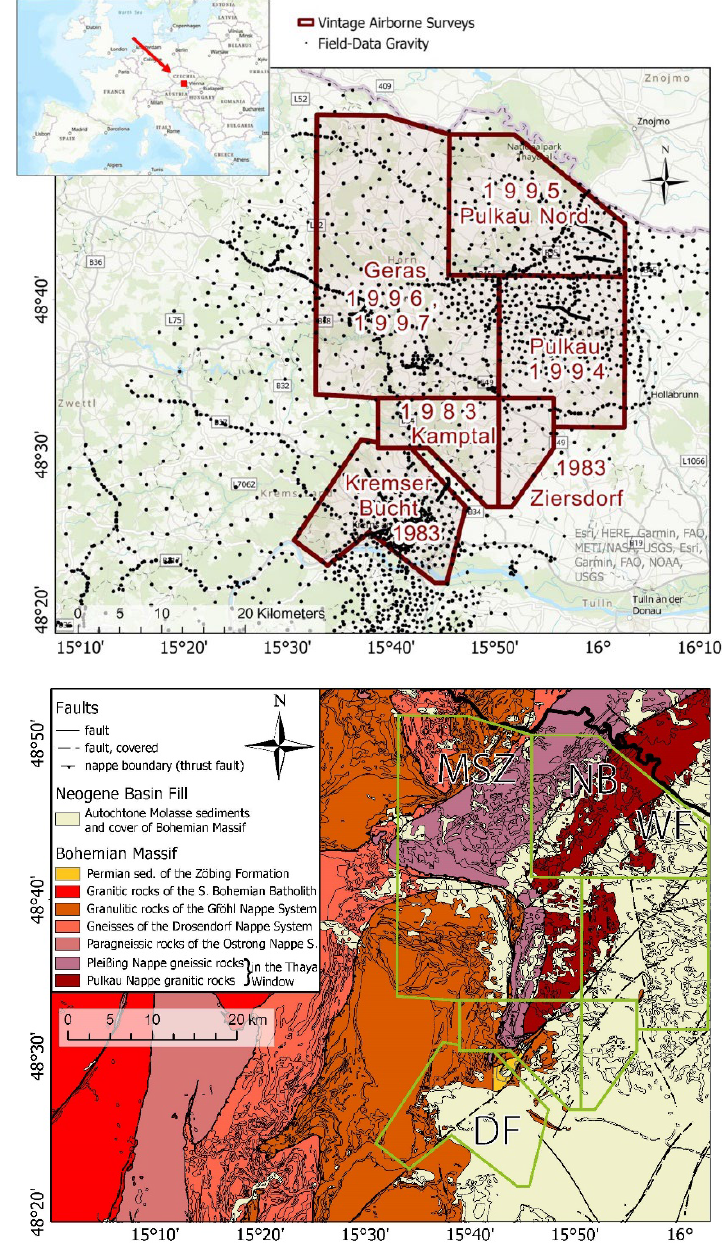
Figure 1. ( a ) Location of provided gravity measurements and airborne datasets acquired in 1983–1997 (inset shows study area location in Europe), background map: open street map. ( b ) Tectonic map of the study area, major faults for this study are marked: DF—Diendorf Fault, MSZ—Moldanubian Shearzone, NB—Nappe boundary between Pleißing and Pulkau nappes within the Thaya Window, WF—Waitzendorf Fault. Location of airborne datasets outlined in green is shown as reference, background map: tectonic units of the geological map of Lower Austria at the scale of 1:200.000, adapted with permission from [15,16], Geological Survey of Austria (GBA), 2022.